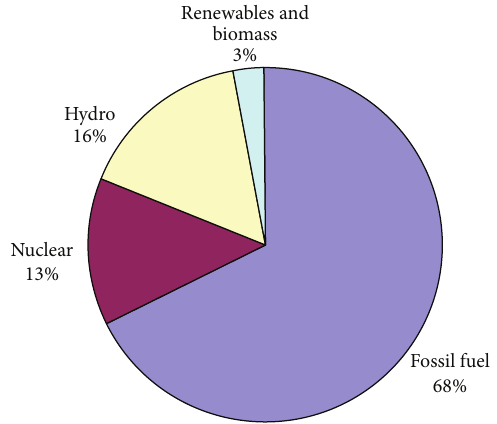
Figure 3: World’s energy mix for generating electricity (2009).